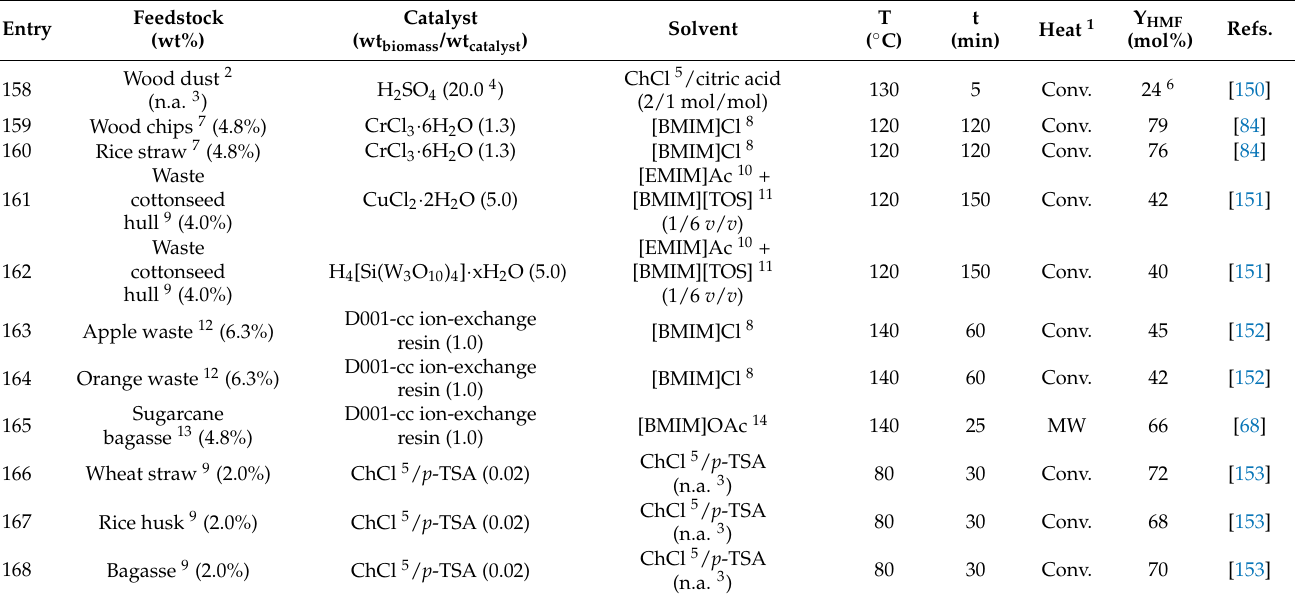
Table 8. HMF production from raw pretreated biomasses in ionic liquids and deep eutectic